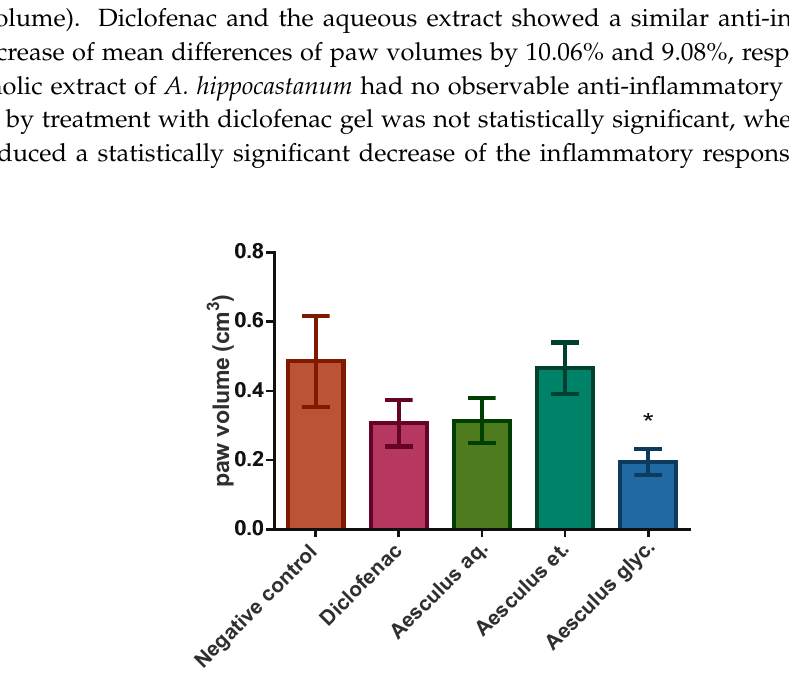
Figure 4. Difference of paw volume between initial and final measurements in the carrageenan inflammation model (mean ± SD). The A. hippocastanum glycerolic extract induced a statistically significant decrease of the inflammatory response (* p < 0.05). The A. hippocastanum ethanolic extract showed no observable anti-inflammatory effect ( p > 0.05). The edema reduction by treatment with diclofenac gel was not statistically significant and was comparable to that observed after treatment with the A. hippocastanum aqueous extact ( p > 0.05).